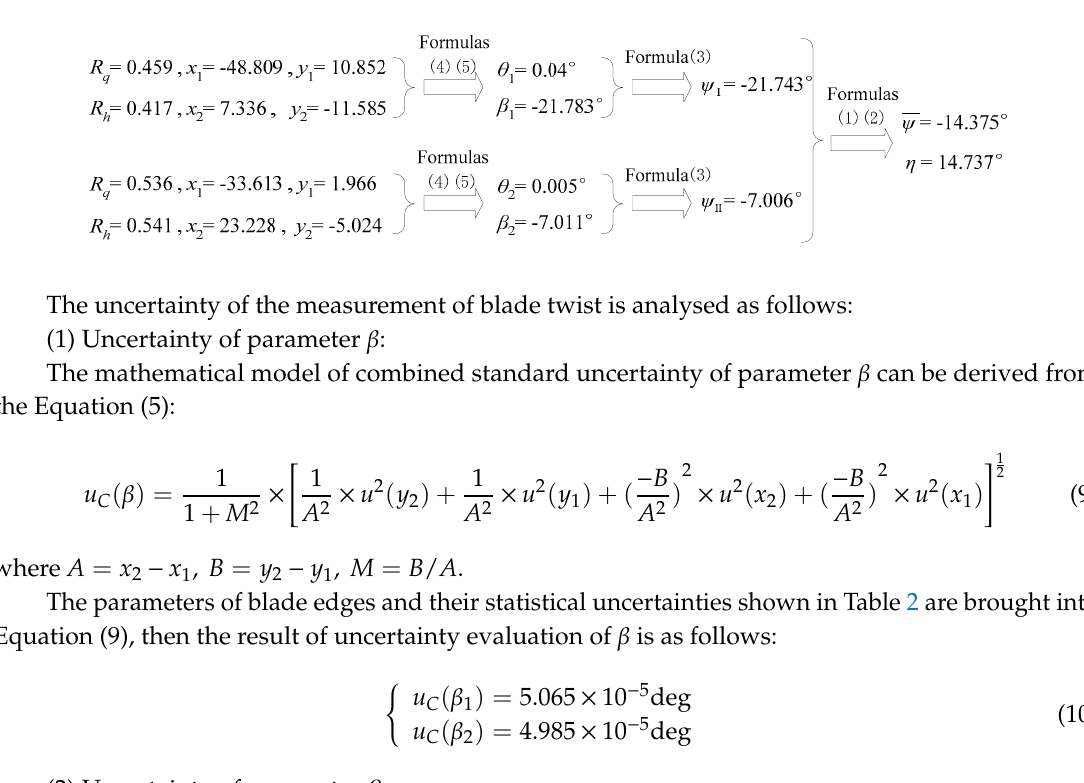
Table 2. Measurement results of the leading and trailing edges (unit: